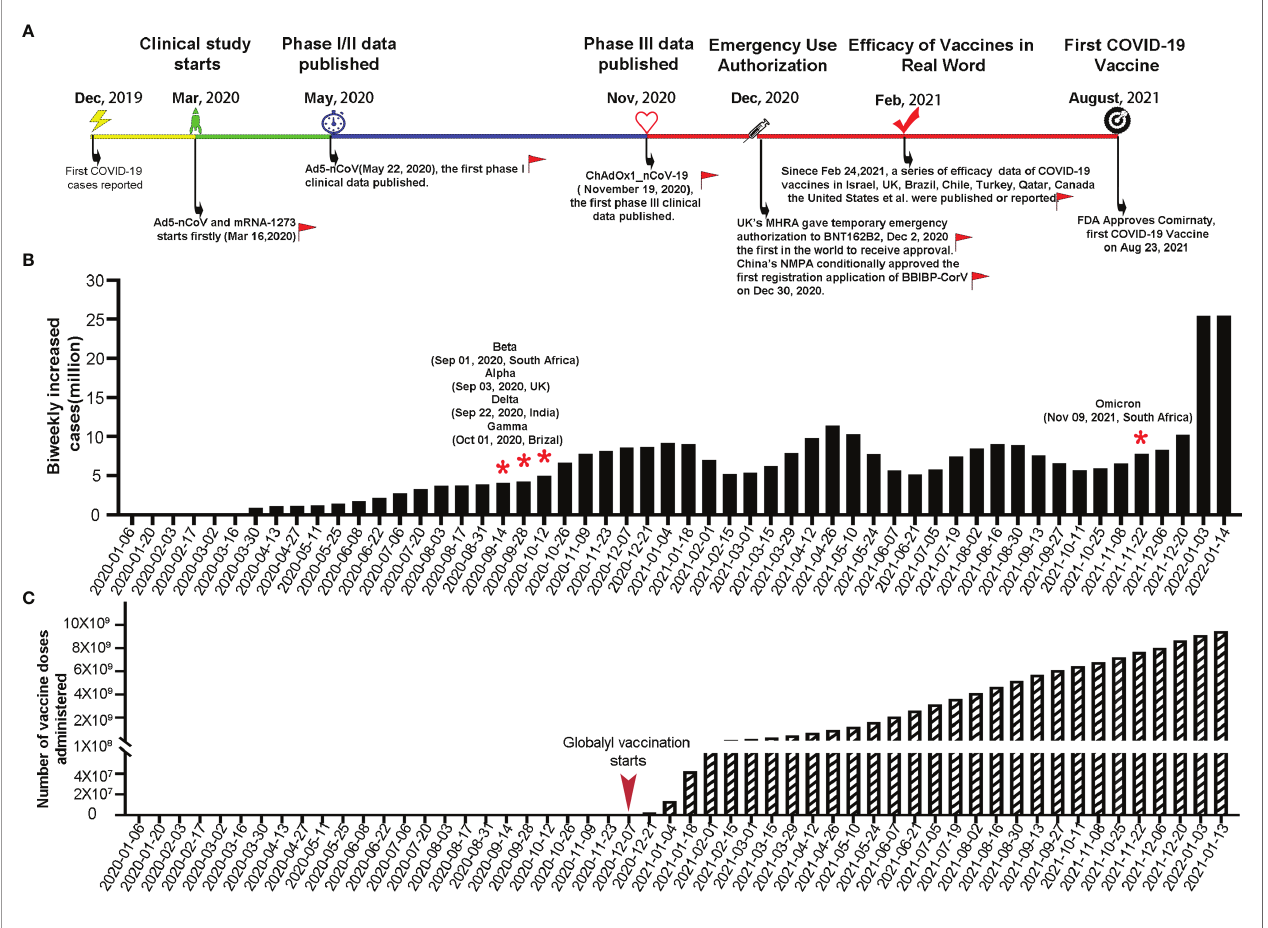
FIGURE 1 | Key milestones in COVID-19 vaccine R&D, biweekly increases in COVID-19 cases worldwide, and total number of COVID-19 vaccine doses administered worldwide. (A) Timeline of the R&D of COVID-19 vaccines. Red fl ags indicate the key milestones in global COVID-19 vaccine R&D and vaccination with the corresponding dates indicated in parentheses. (B) Biweekly increases in COVID-19 cases worldwide with red stars denoting the time points of emergence of SARS − CoV − 2 variants (data source: https://covid19.who.int/, https://cov-lineages.org/index.html). (C) Total number of COVID-19 vaccine doses administered worldwide (data source: